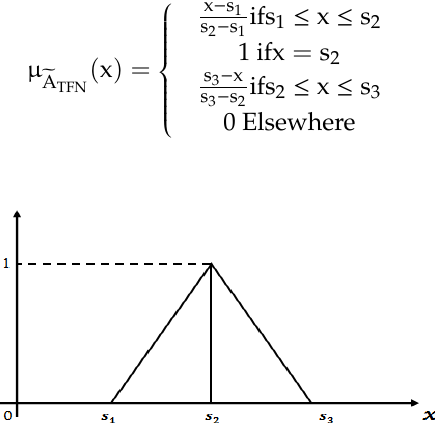
Figure 1. Graphical representation of linear triangular fuzzy number .